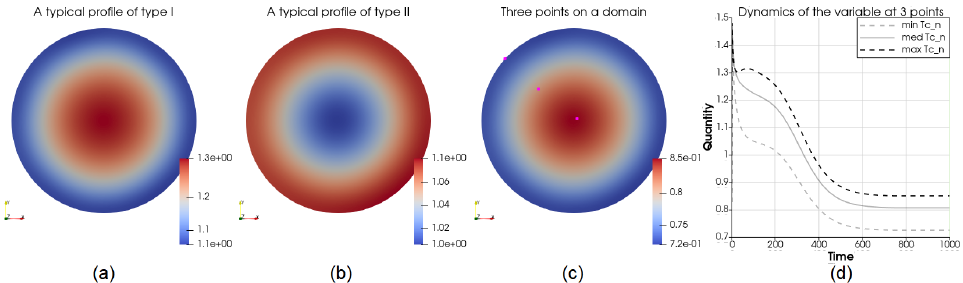
Figure A1. Common types of profiles in this paper. In part ( a ), the center has the highest density, the density reduces in the positive radial direction, and near the boundary takes its lowest value. This is because of the initial conditions of an influx through the boundary. Part ( b ) shows the opposite case. In part ( c ), three points are selected with different distance from the center. In part ( d ), the dynamics are plotted to show how much the density in the center is different from the boundary. Table A3. A report of different experiments using no-flux boundary condition.